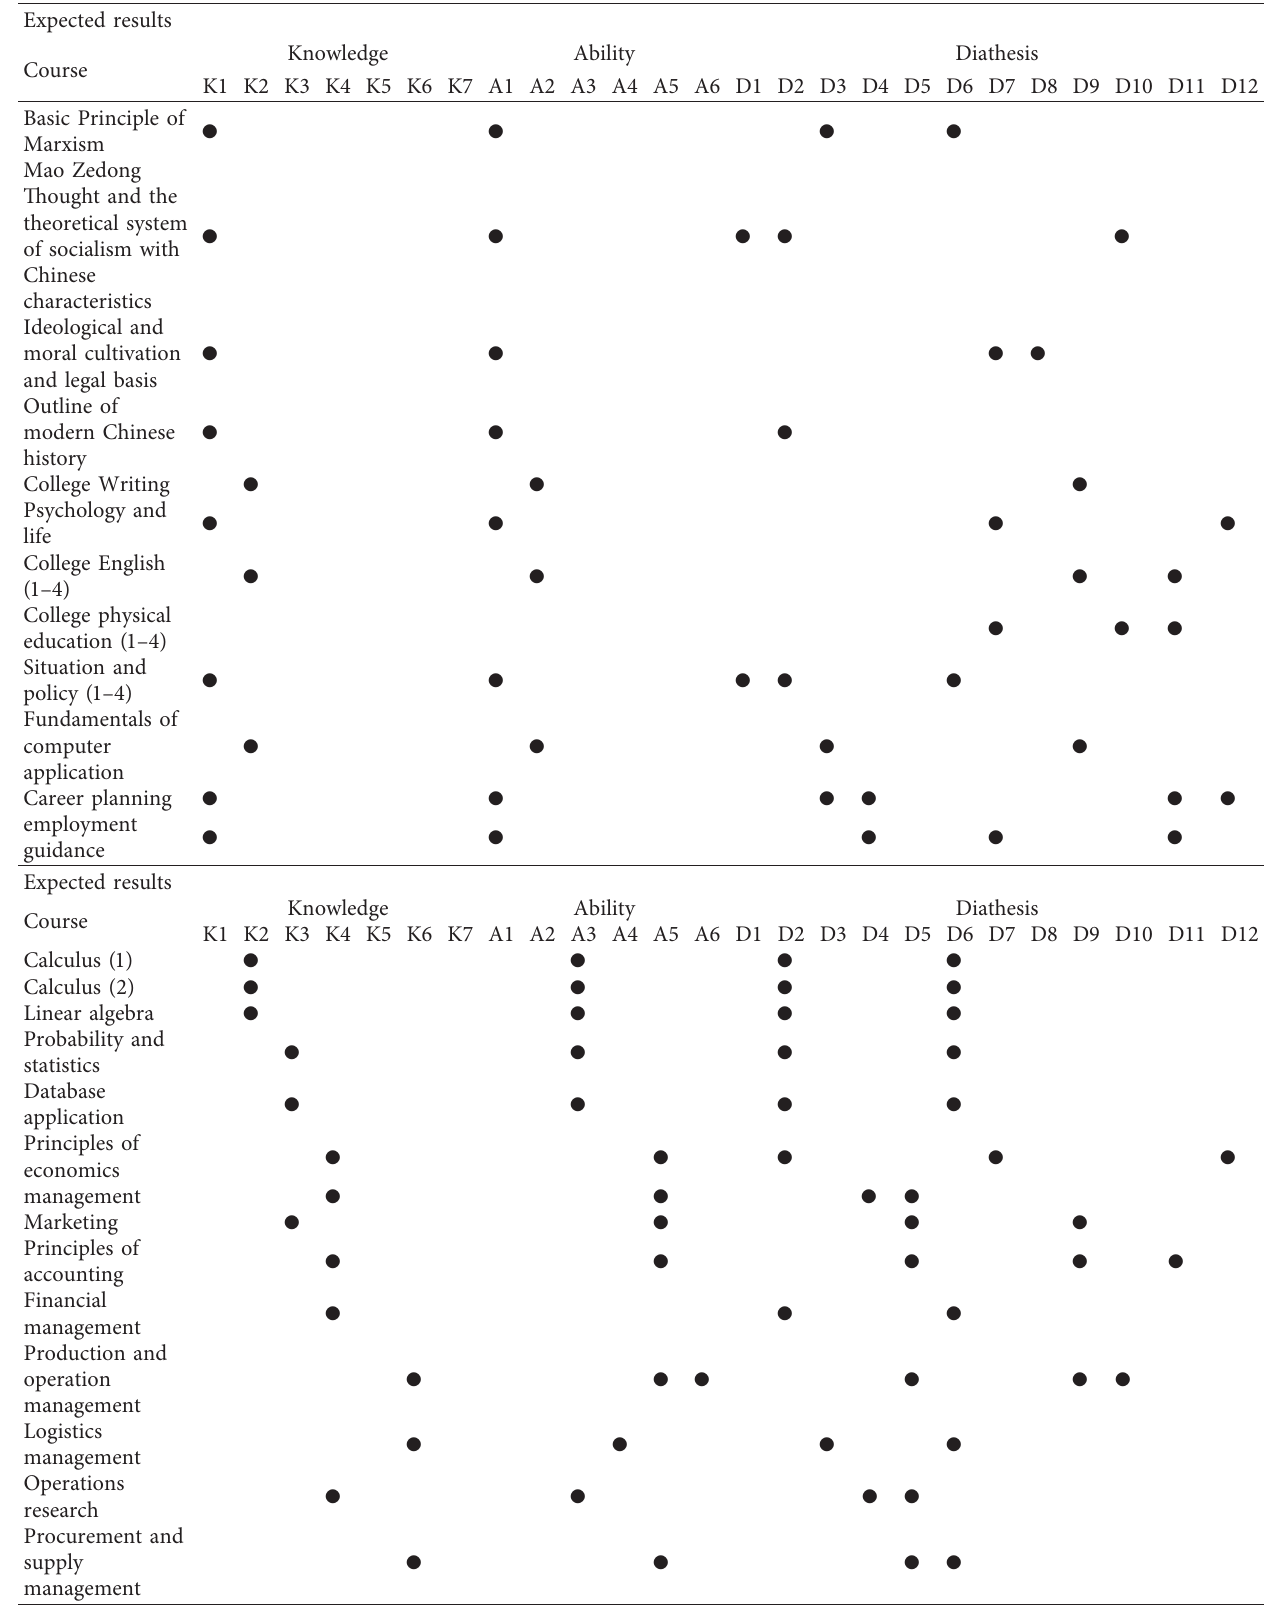
Table 3: Corresponding relation of knowledge, ability, diathesis, and